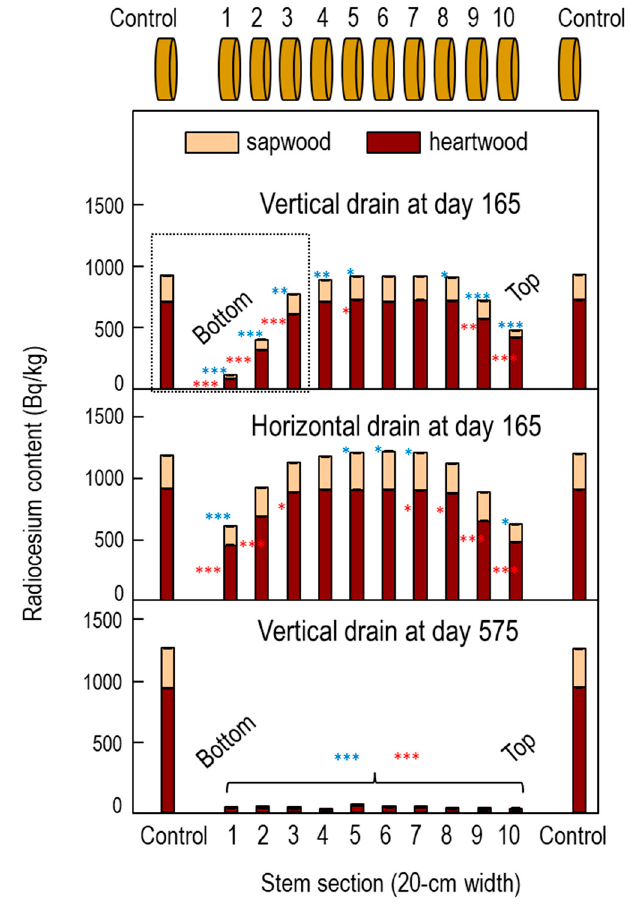
Figure 1. Ponding experiments for the stems of Japanese cedar from Fukushima forest. Level of radiocesium decontamination in 2-m stems. The dotted box was further analyzed in Figure 3. Bar plot the average ± SD of the data from three measurements. Significance at the * p < 0.05, ** p < 0.01, and *** p < 0.001 levels compared with non-treated stems (red, heartwood; blue, sapwood) in Student’s t-test and indicated.